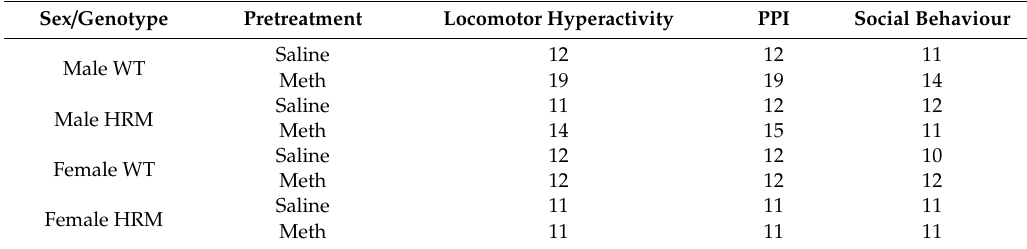
Table 1. Number of animals per group per behavioural